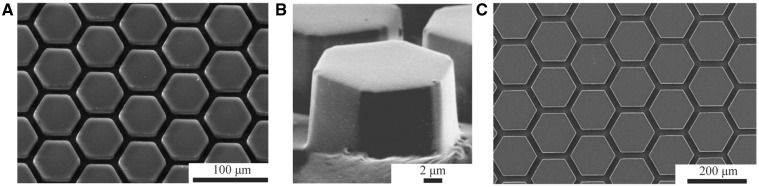
Examples of tree-frog-inspired ‘smooth’ adhesives. (A) Hexagonal PDMS surface pattern for friction under dry conditions (Murarash et al. 2011), (B) Hexagonally micropatterned PDMS surface for capillary adhesion (Drotlef et al. 2013), (C) Hexagonal PDMS surface for friction under wet conditions. See also Table 1. All panels reproduced with permission.